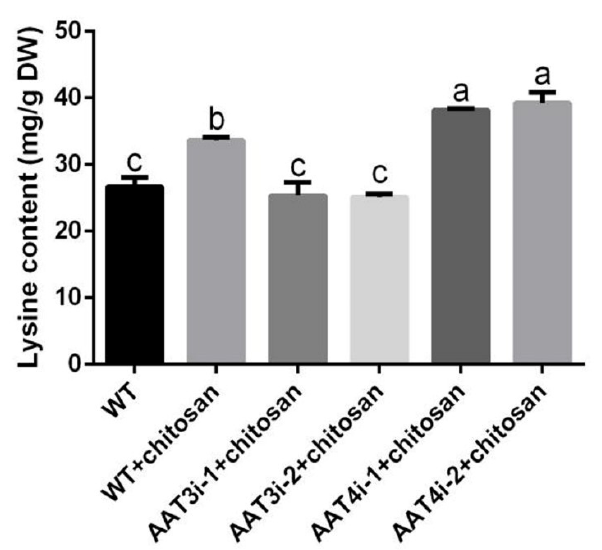
Figure 7. AAT3 and AAT4 were involved in the biosynthesis of lysine in F. filiformis with chitosan treatment. Lysine content in F. filiformis treated with chitosan was determined. The calculation results are presented as mean ± standard deviation, and different letters indicate significant differences between different treatments ( p < 0.05).